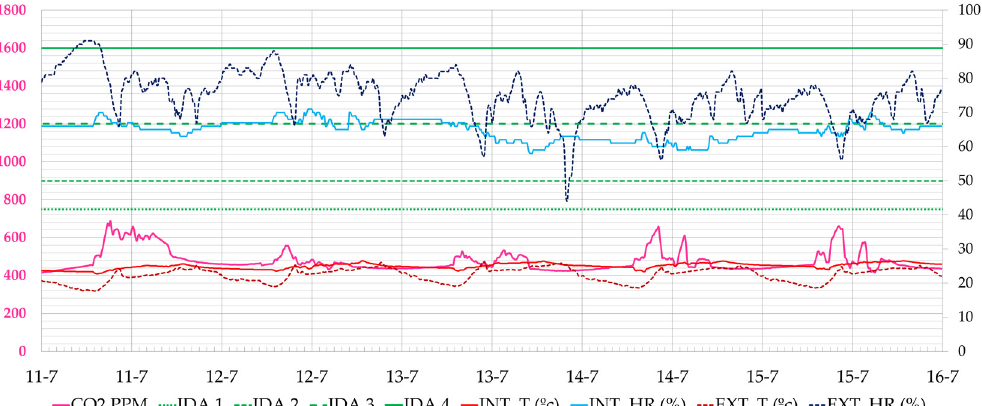
Figure 22. Evolution of CO 2 concentration, interior and exterior temperature and relative humidity in the administration office during the week of 11–15 July 2022 (Phase III). Source: authors. In the hygrothermal comfort analysis model, we see (Figure 23) how the most nega- tive effect that the air flow from the outside can have is that it contributes an excess of fort model.